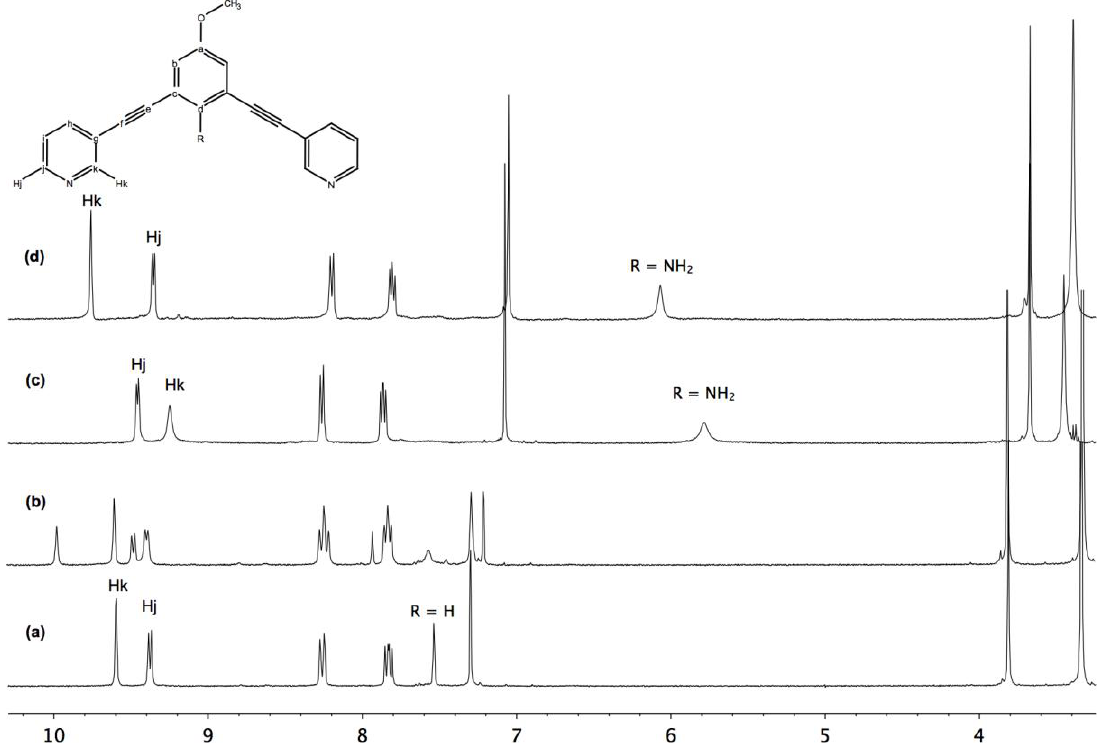
 n -Bu N  inside the metallocages [Pd 4 4 2 ( L 2 ) ][OTf] 3 in DMSO -d . ( a ) Cage 1b ; ( b ) addition of one equivalent of 2 4 4 6